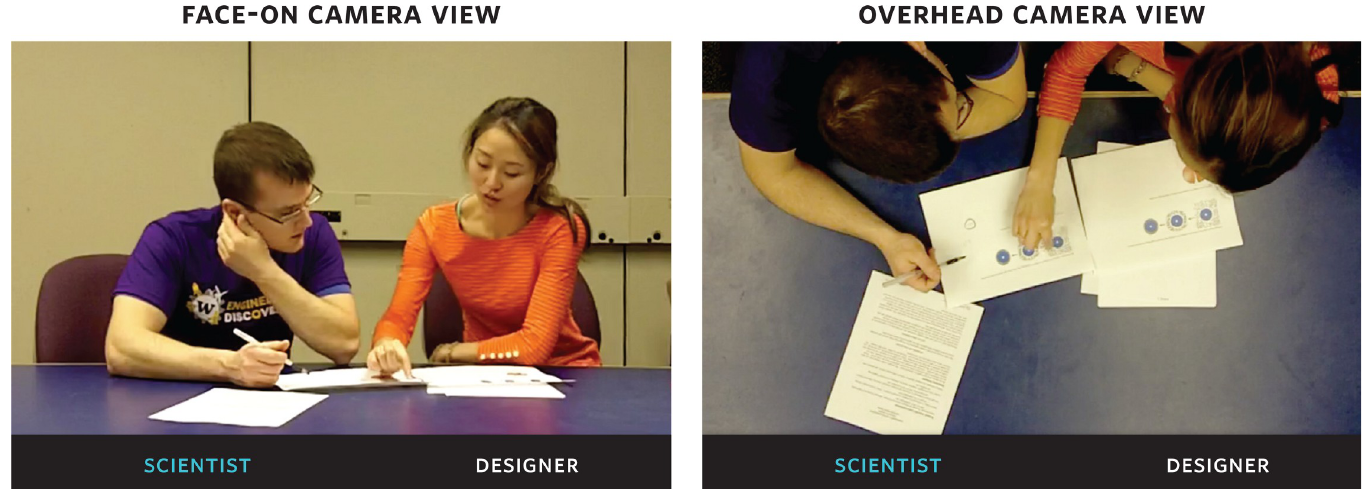
Fig 1. Camera setup at the design help desk. At the Design Help Desk the scientist was always seated on the left and the designer on the right.The image on the left shows the “Face-On View” which captures the frontal expressions, gestures and body language of both participants. The image on the right shows the “Overhead Desk View” which captures the gestures of both participants on the desktop, including interactions with the graphic printouts on the desk.